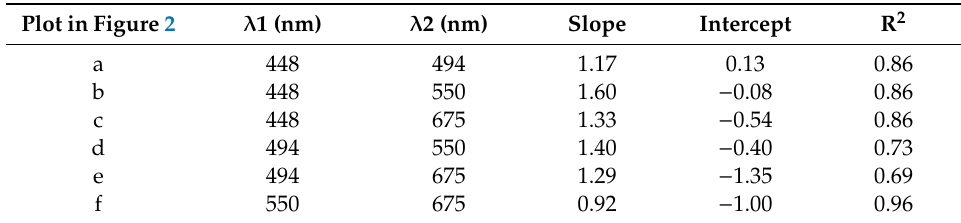
Table 2. Band value comparison from the in-situ data collected with all 4 multispectral sensors from orthogonal regression taking wavelength bands 2 by 2 and providing slope, intercept and (R 2 ). The corresponding plots in Figure 2 are indicated for